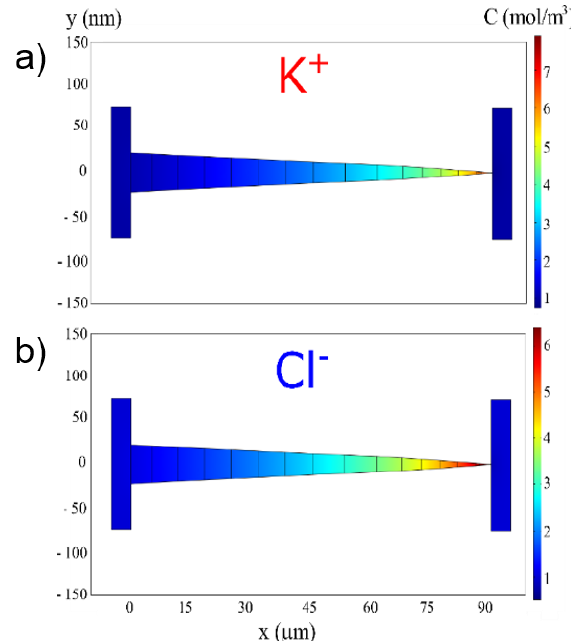
Figure 10. K + ( a) and Cl − ( b ) concentrations in the nanofluidic device at C Bulk 10 −3 M (1 mol/m 3 ), with -10 V applied between the reservoirs. Ion accumulation in the funnel for both ionic charges is clearly visible.